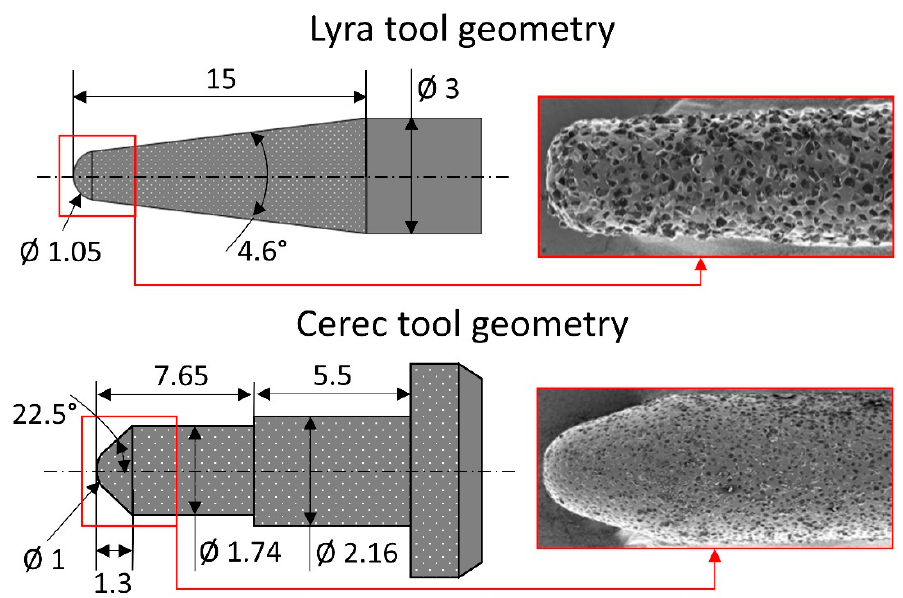
Figure 1. Geometry of the two tools used in the study (all lengths and diameters in mm).